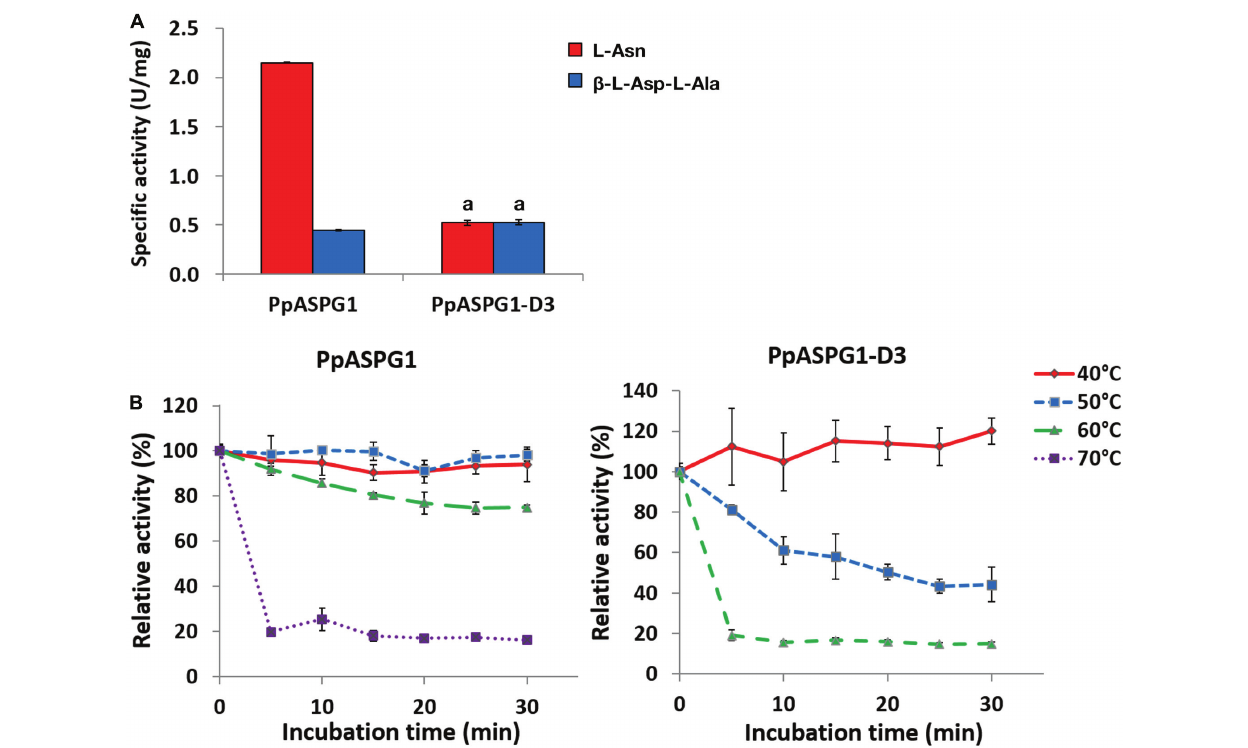
FIGURE 6 | Effect of removing the VL on substrate preference and thermal stability of PpASPG1. Recombinant proteins PpASPG1 and PpASPG1-D3 (see Figure 4A for a schematic representation of the structure) were purified from agroinfiltrated tobacco leaves, and compared for substrate preference and thermal stability. (A) Catalytic activity was determined in a buffered medium containing 25 mM of the substrates asparagine or isoaspartyl-alanine dipeptide. Values are means of three replicates ± SD. Values labeled with the same letter are not significantly different according to t -tests ( p < 0.01). The remainder values are significantly different. (B) The purified recombinant proteins were incubated at different temperatures. Aliquots were removed every 5 min and kept on ice until residual ASPG activity was measured. Values are means of three replicates ± SD. For PpASPG1, the residual activity values after incubating at 70 ◦ C are significantly different to those observed after incubating at 40 ◦ , 50, and 60 ◦ C according to t -tests ( p < 0.01). The residual activity values after incubating at 50 or 60 ◦ C are significantly different only after incubating 25 and 30 min. The remainder values at the same incubation time are not significantly different. For PpASPG1-D3, all residual activity values after the same incubation time are significantly different according to t -tests ( p < 0.01), except for values after incubating for 5 min at 40 and 50 ◦